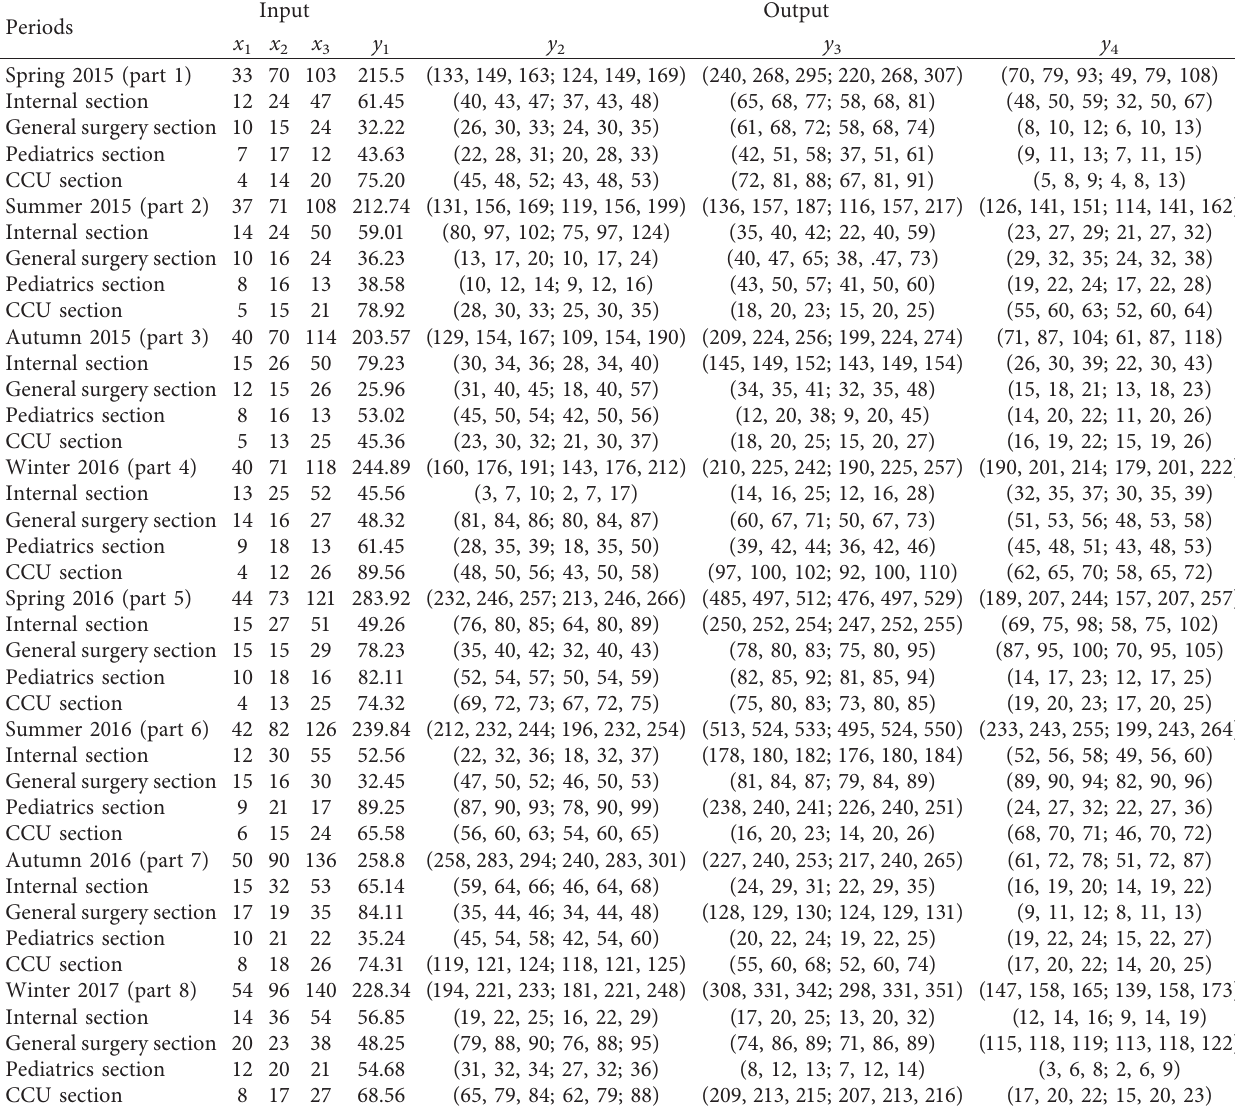
Table 9: Input and output of Imam Khomeini hospital